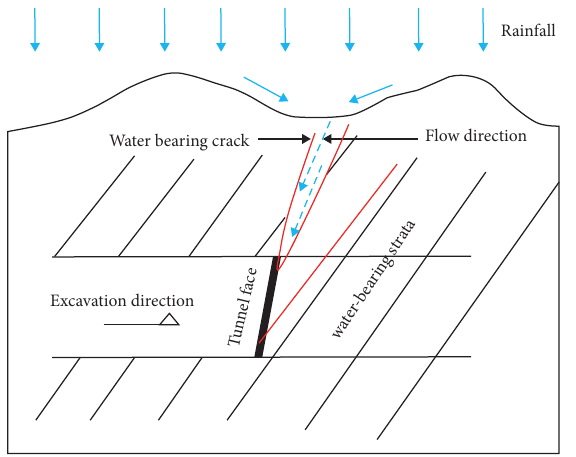
Figure 3: Diagram of water inrush in a water-bearing crack.